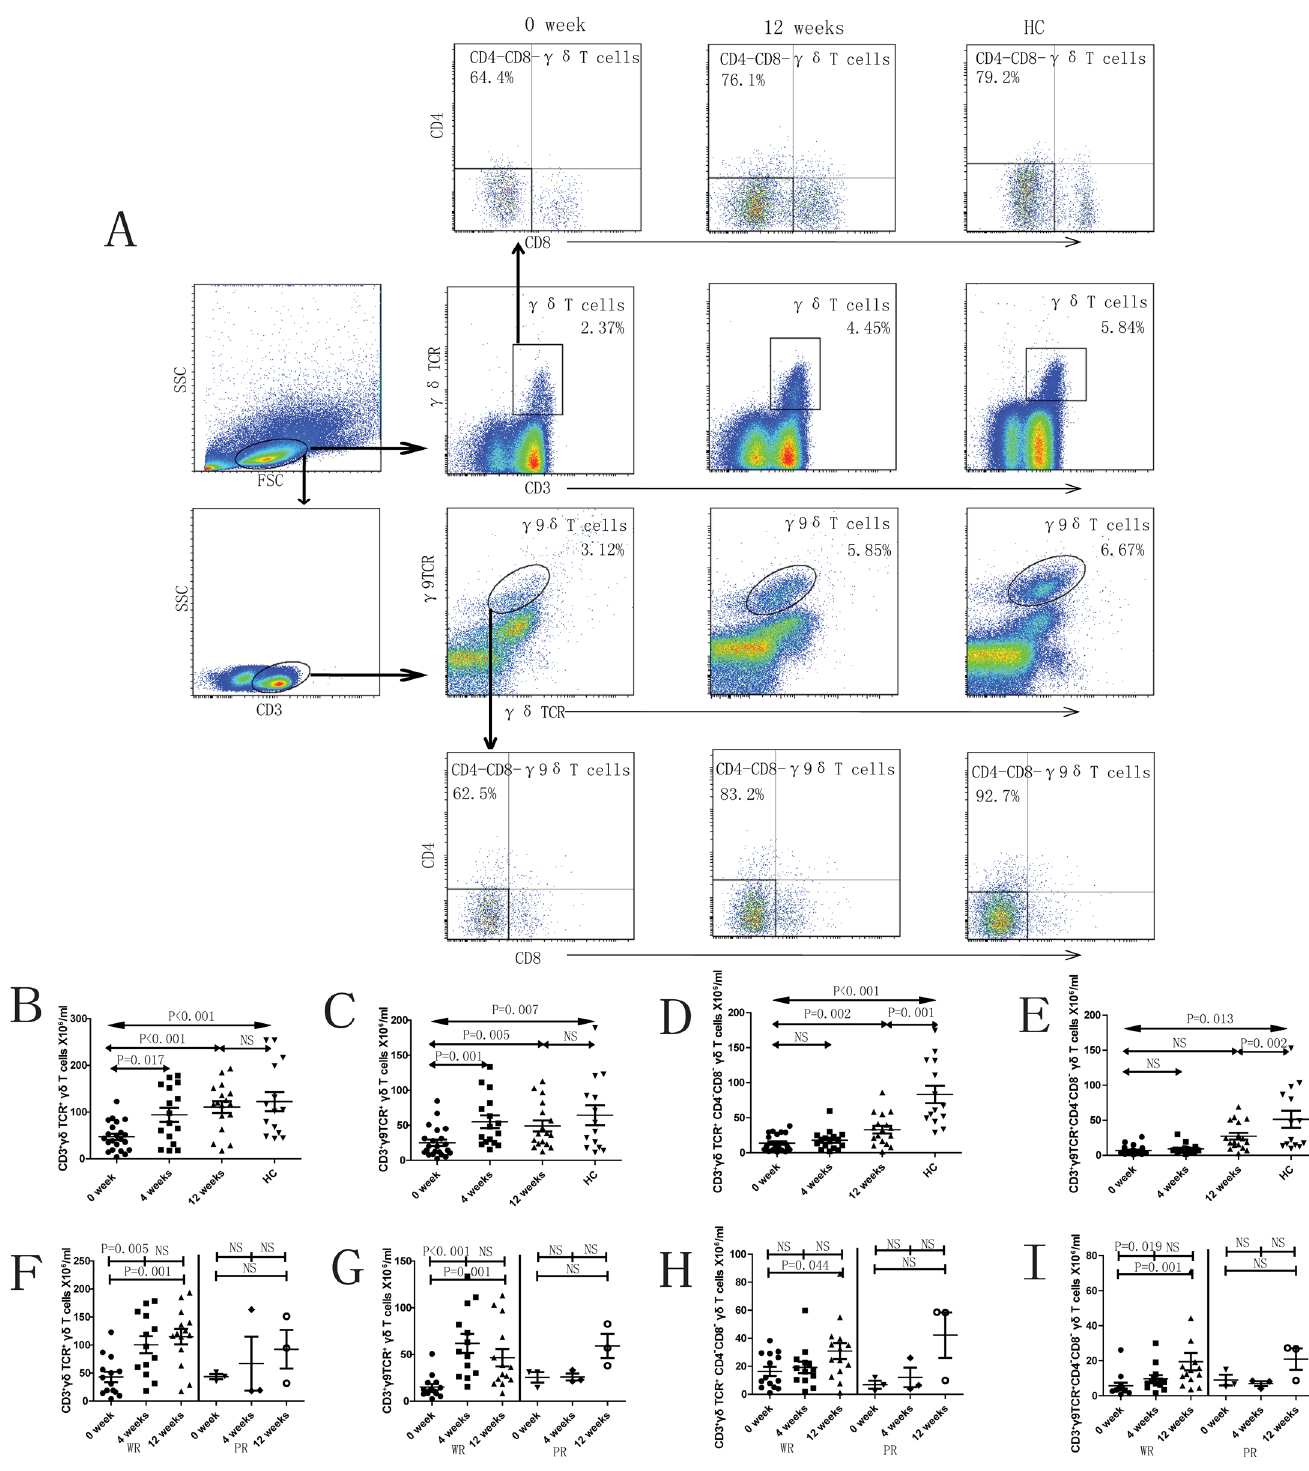
Fig 1. Peripheral blood γδ T cells and subsets in SLE patients. A. The panels in this section show the gating strategy employed for the analysis of γδ T cells and subsets. Peripheral venous blood derived leukocytes were stained with different fluorescent antibodies and after lysis of red blood cells, the remaining cells were gated on living lymphocytes, then gated on CD3 + γδ TCR + or CD3 + γδ TCR + γ 9TCR + cells, and then further gated on CD4 - CD8 - cells, respectively. B — I. Flow cytometry results are represented as the scatter dot plots of γδ T cells and subsets in healthy controls (HC) or in SLE patients before and after therapy (treatment time is indicated). SLE patients are further grouped as responders (R) and non-responders (NR) based on response to therapy.